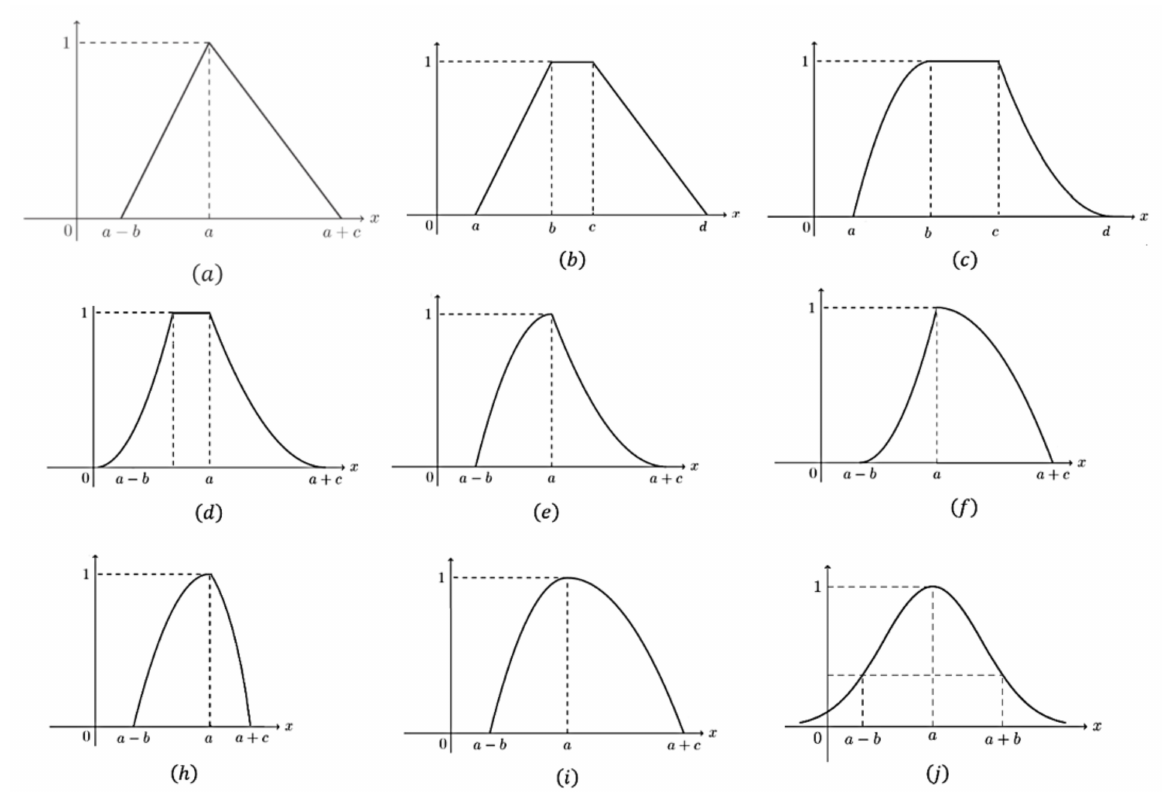
Figure 1. Various types of fuzzy